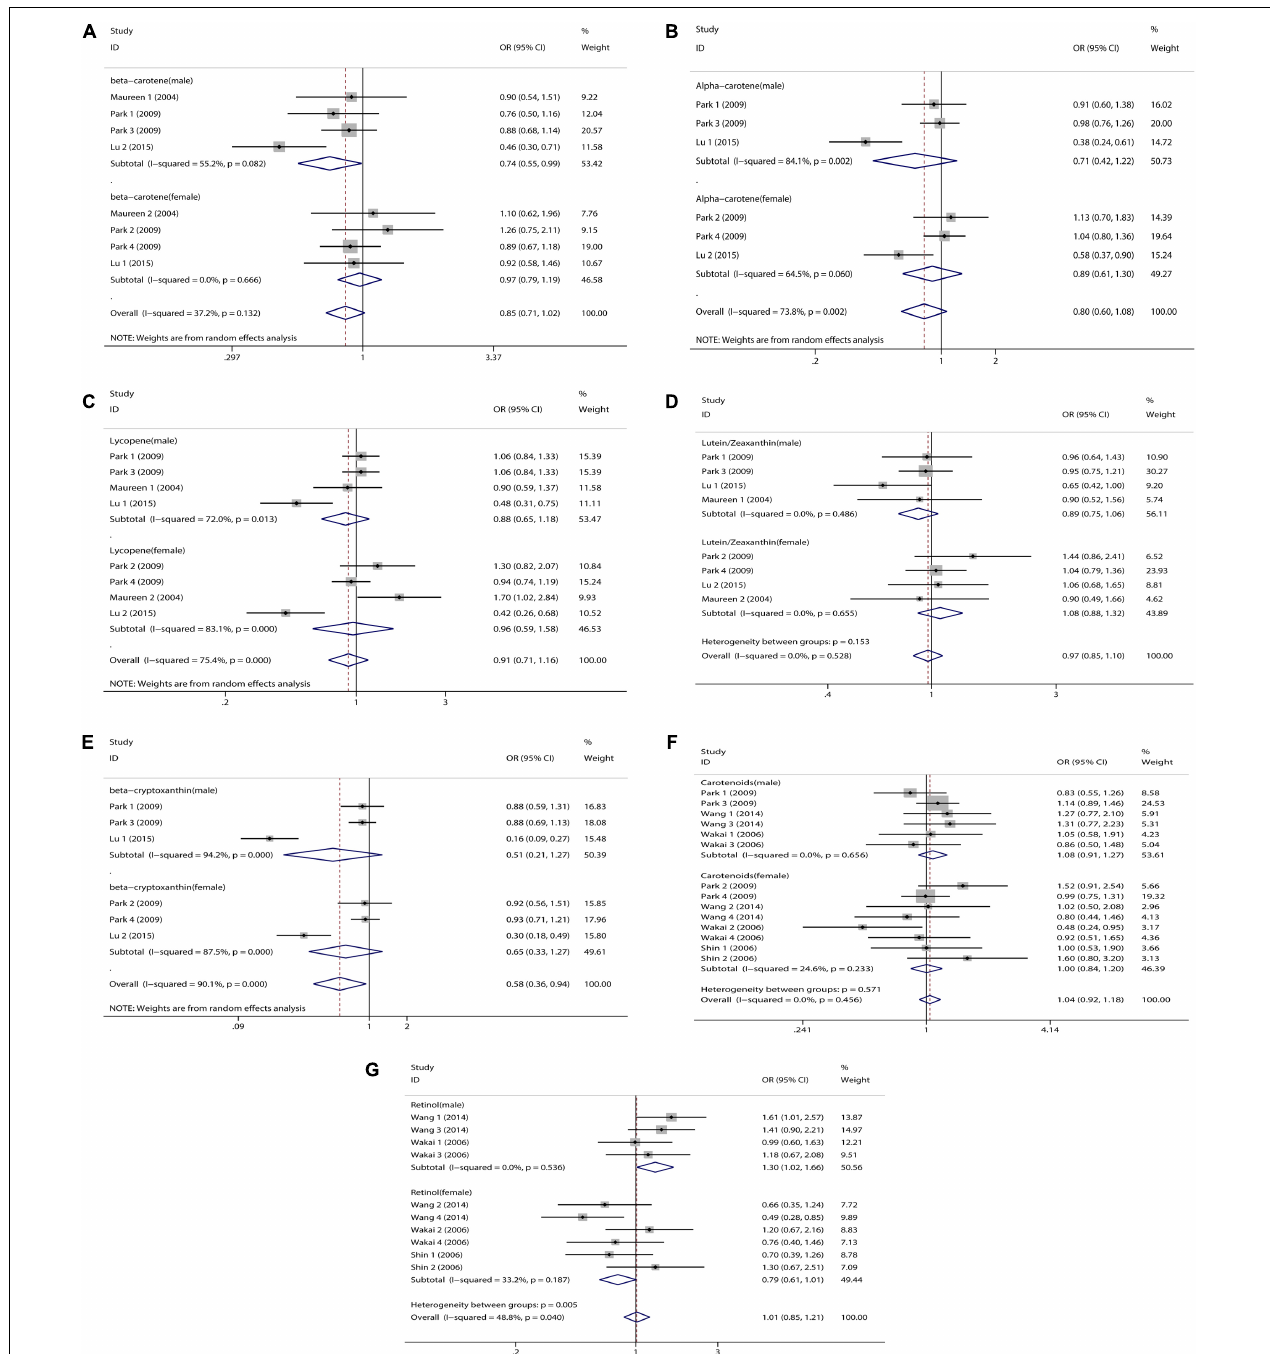
FIGURE 5 | Sex subgroup analysis of dietary carotenoid and retinol intake and colorectal cancer risk. (A) β -carotene; (B) α -carotene; (C) lycopene; (D) lutein/zeaxanthin; (E) β -Cryptoxanthin; (F) carotenoids; (G) retinol.